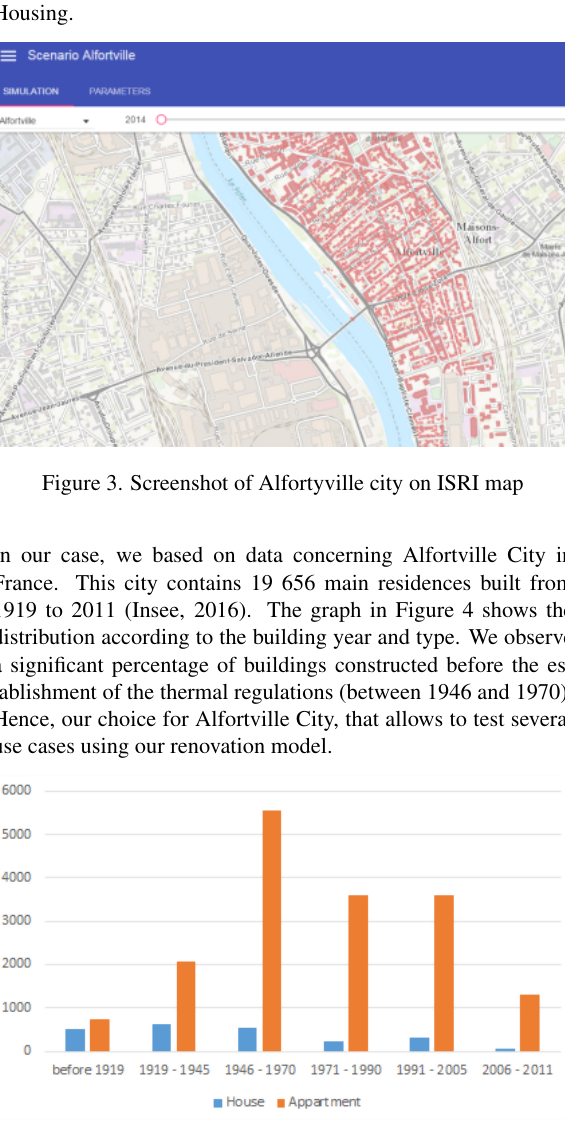
Figure 4. Alfortville residential buildings according to its